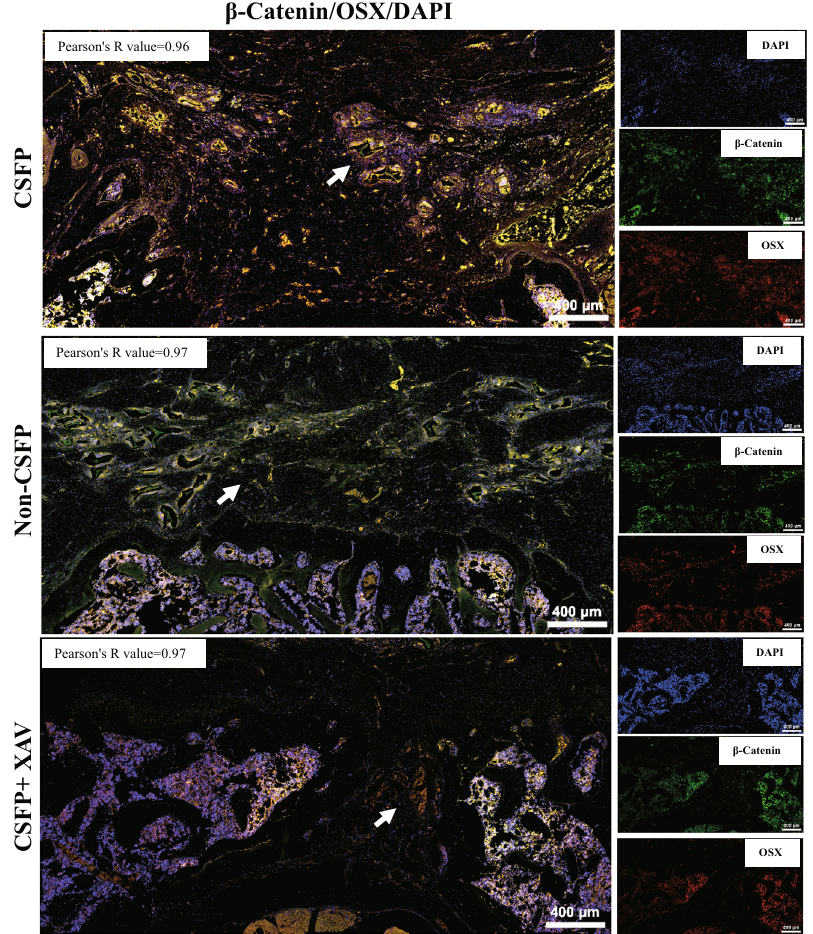
Fig. 6 Double immuno fl uorescent staining revealed colocalization of β -Catenin (green) and Osterix (red). The white arrow shows the